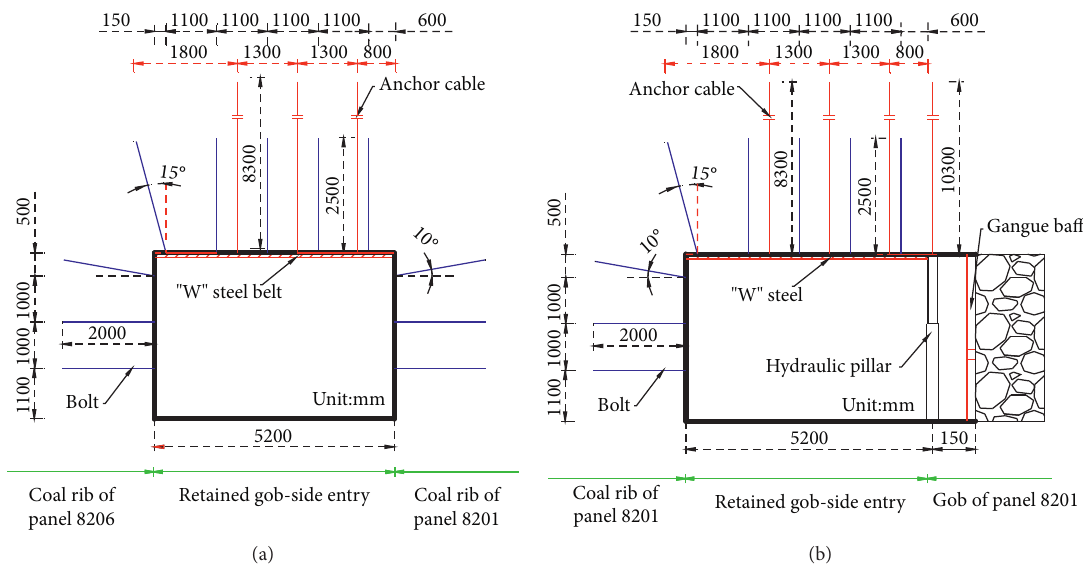
Figure 4: Supports of gob-side entry 5201. (a) Before panel 8201 retreats. (b) After panel 8201 retreats.